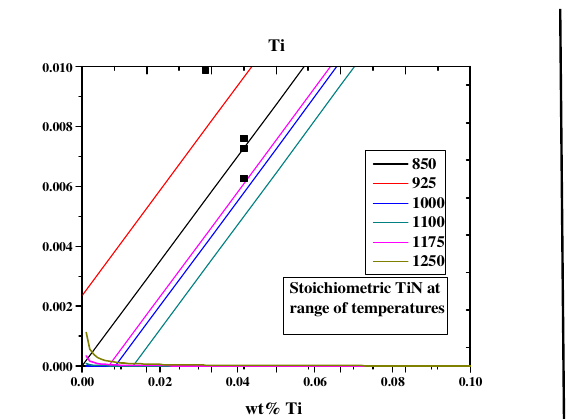
Fig. 10: Stoichiometric Calculations of TI and N Mathematical calculation was performed to know and verify theoretically the exact amount of nitrogen needed to form the precipitates when nitrogen combines with titanium. The calculation is shown in Table 2. Thermodynamic calculation can also be performed for aluminum with nitrogen (Log ([Al] [N]) = 1.03 - 6770/T) and titanium with nitrogen (Log ([Ti] [N]) = 3.82 - 15020/T).